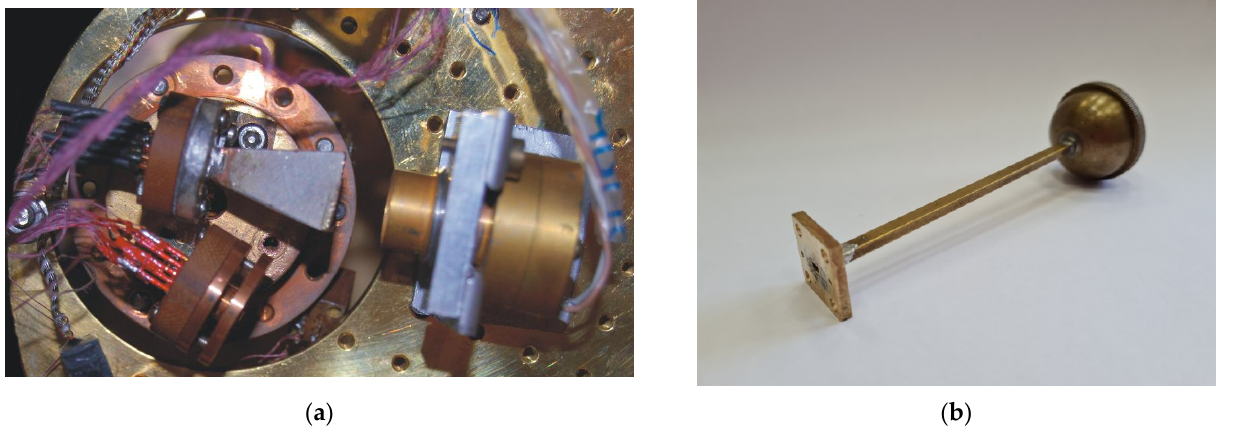
Figure 9. ( a ) Integrating cavity with NiCr film on sapphire substrate at 2.8 K stage in cryostat with the sample (left) at 280 mK stage; ( b ) photo of spherical integrating cavity for measurements with P2-69 SWR meter.